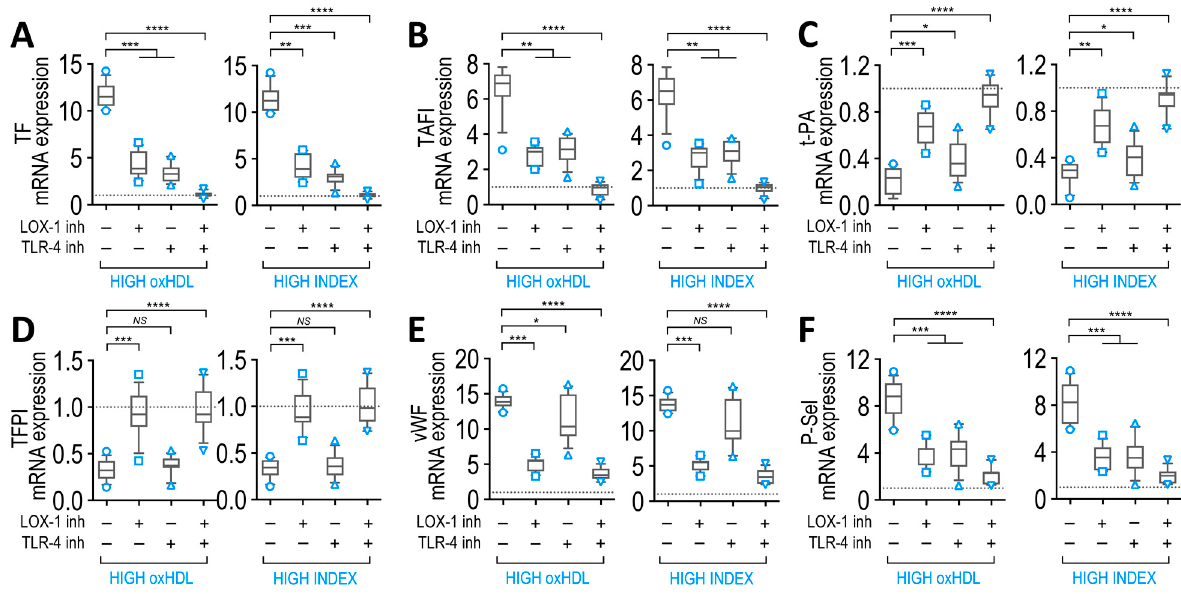
Figure 8. Effects of LOX-1 and TLR-4 recepto inhibitors in coagulation factors and platelet adhesion protein mRNA expression in cultured EC exposed to plasma from SSP. Plasma samples were collected from high-oxHDL and high-INDEX SSP blood samples and then added to cultured EC for 24 h, in the absence ( − ) or presence (+) of the neutralizing antibody against LOX-1 function (LOX-1 inh) and the TLR-4-specific inhibitor CLI-095 (TLR-4 inh), and then mRNA expression of coagulation factors and platelet adhesion proteins were measured. Normalized mRNA expression of TF ( A ), TAFI ( B ), t-PA ( C ), TFPI ( D ), vWF ( E ) and P-Sel ( F ) were measured in EC cultures exposed to high-oxHDL (left panels) and high-INDEX (right panels) plasma samples. Statistical differences were assessed by a one-way analysis of variance (ANOVA) (Kruskal–Wallis) followed by Dunn’s post hoc test. * p < 0.05, ** p < 0.01, *** p < 0.001, **** p < 0.0001. Values are expressed as the median ± 10-90 percentile. NS: non-significant. Dotted line depicts normalized expression obtained in non-treated EC cultures.